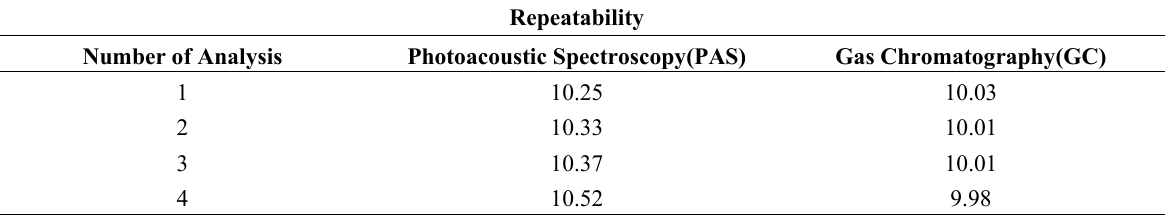
O analysis methods (units: 2